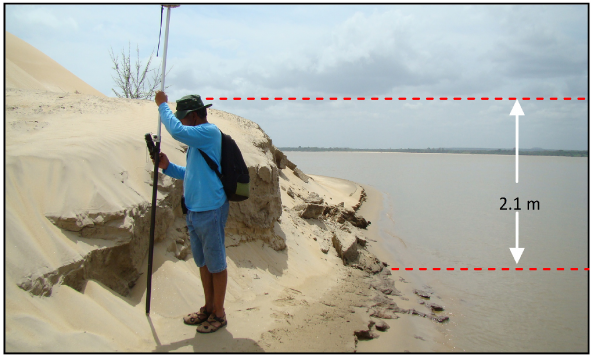
Figure 3. The banks of the mid-channel bar (study area) are asso- ciated with highly erodible unconsolidated